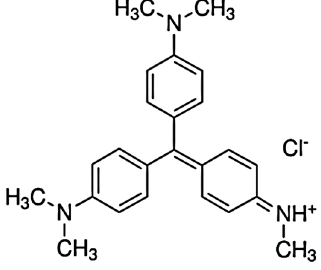
Figure 1. Structure of Methyl Violet 2B